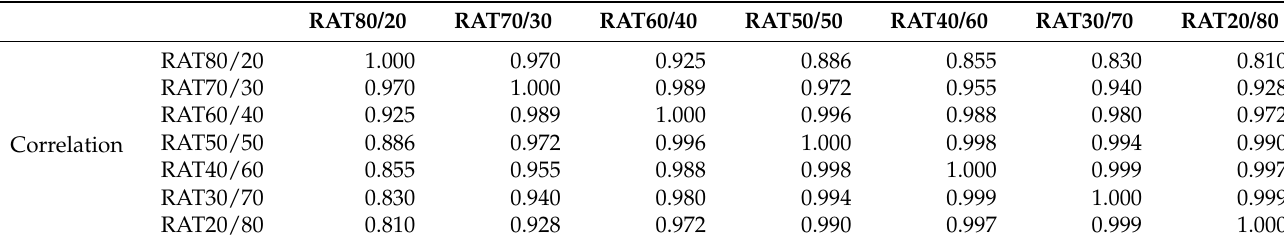
Table 1. Correlation matrix.